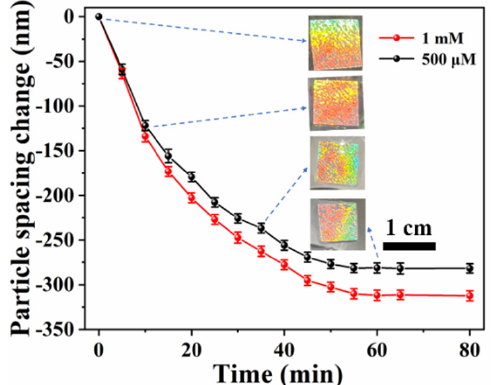
Figure 6. Time dependence of the particle spacing changes for DNA − H1 − 960 hydrogel aptasensor in 500 μ M and 1 mM lysozyme solutions (Insets: the photographs of DNA − H1 − 960 at different response time). The scale bar “1 cm” represents the size of the photographs. The particle spacing decreased sharply within 10 min and achieved the response equilibrium at 60 min. The size of the hydrogel was obviously decreased along a longer reaction